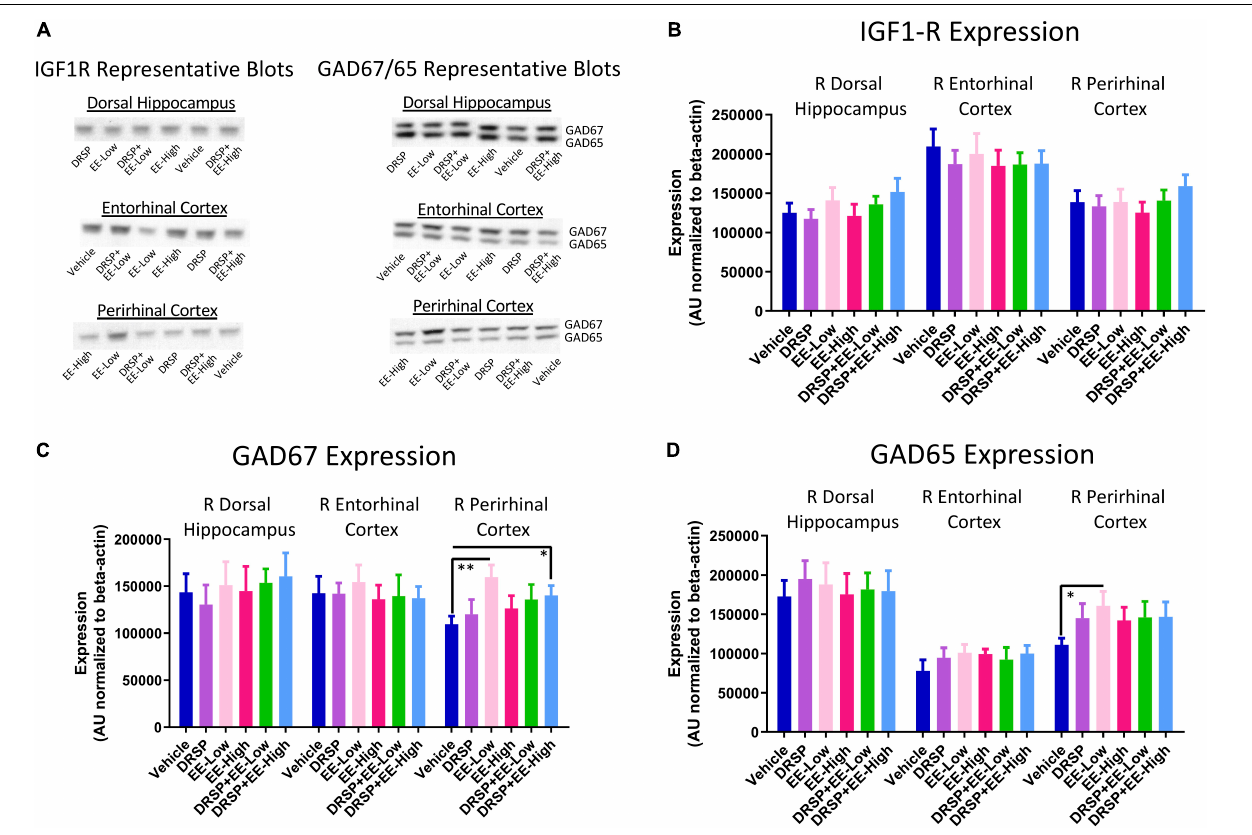
FIGURE 8 | Experiment 2 Western blot protein analysis. (A) Representative images of IGF1-R, GAD65, and GAD67 western blot analysis within the dorsal hippocampus, entorhinal cortex, and perirhinal cortex. (B) There were no differences in IGF1-R expression between groups in any brain region evaluated. (C) Rats treated with a low dose of EE or drospirenone plus a high dose of EE showed increased GAD67 expression in the perirhinal cortex compared to rats without hormone treatment. No differences in GAD67 were detected between groups in the dorsal hippocampus or entorhinal cortex. (D) Rats treated with a low dose of EE had increased GAD65 expression in the perirhinal cortex compared to rats without hormone treatment. No differences in GAD65 were detected between groups in the dorsal hippocampus or entorhinal cortex. ∗ p < 0.05 and ∗∗ p < 0.01. Vehicle n = 10, DRSP n = 10, EE-Low n = 10, EE-High n = 10, DRSP + EE-Low n = 10, and DRSP + EE-High n =